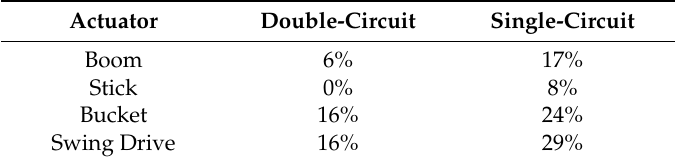
Table 1. Analysis of 90 Degree Digging Cycle, %-Share of Time of Δ p being bigger than 60 bar in Figure 5. Actuator Double-Circuit Single-Circuit